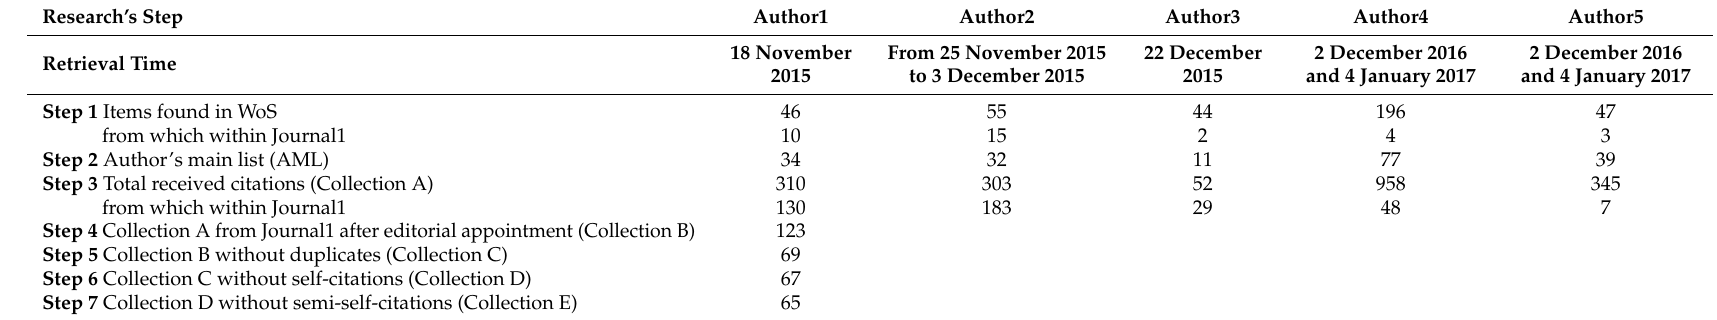
Table 1. WoS’s publications and citation records for Author1, Author2, Author3, Author4, and Author5, as were registered after performing our research